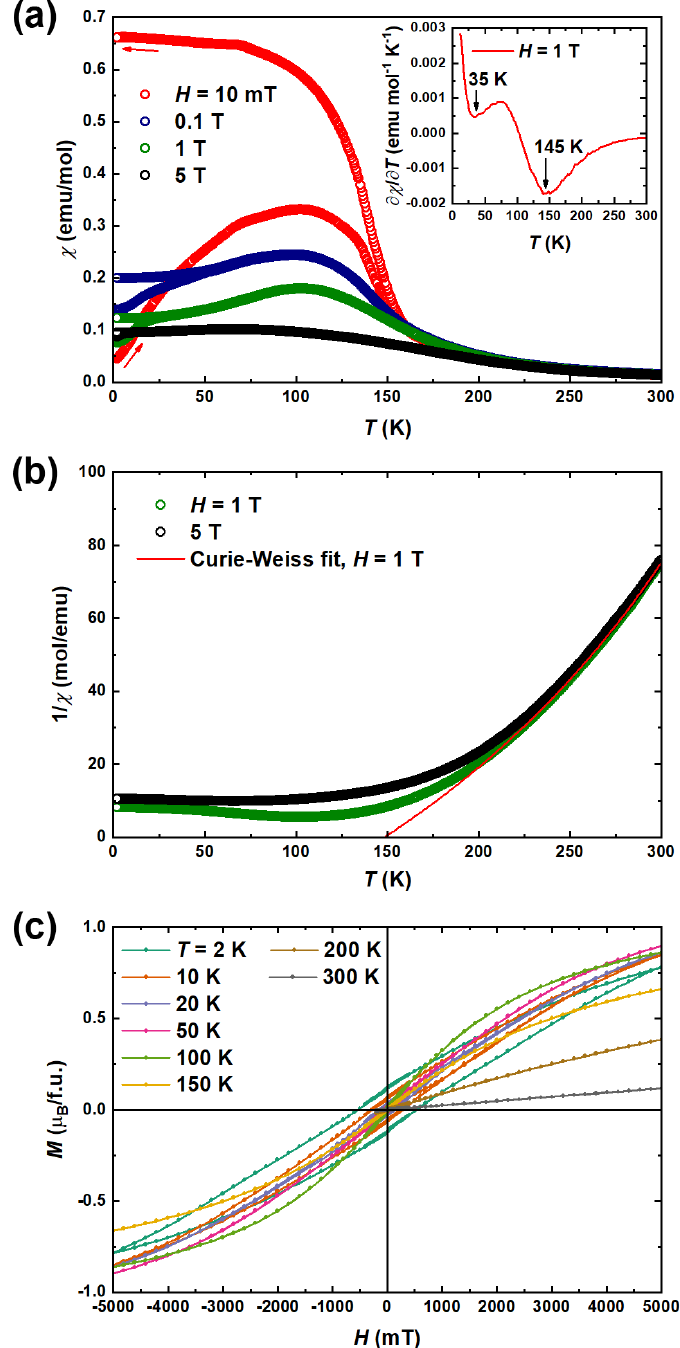
Figure 5. Magnetic susceptibility ( a ), inverse magnetic susceptibility ( b ) and magnetization ( c ) of Mn 1 − x Re x Ge (x = 0.169(6)). The inset shows a first-order derivative of the ZFC susceptibility in 1 T magnetic field.